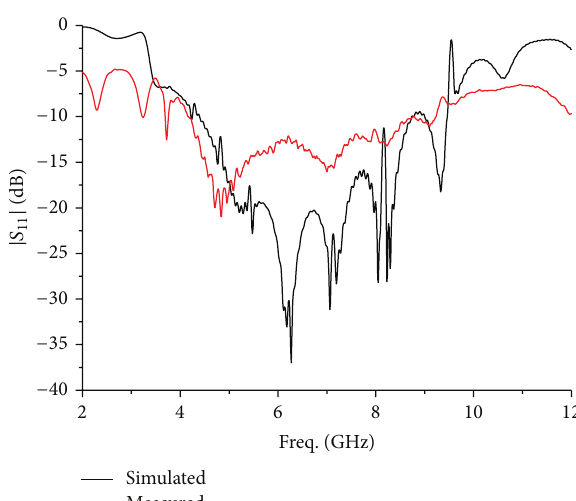
Figure 6: Prototype antenna.